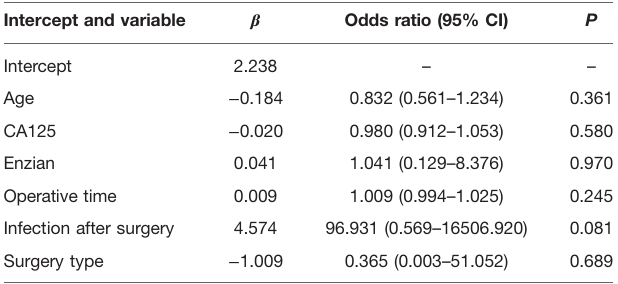
TABLE 2 | Risk factors for abnormal defecation after surgery of intestinal deep